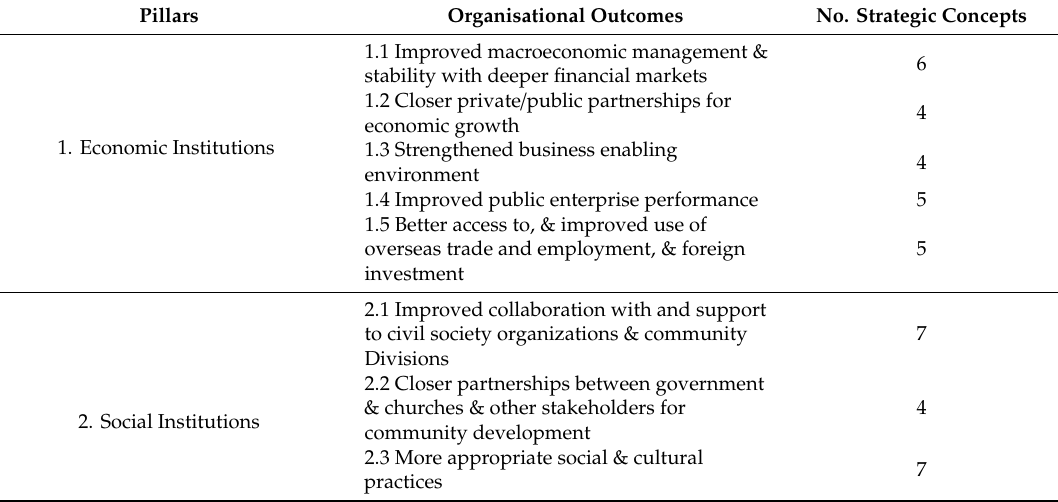
Table A1. The Pillars and associated Organisational Outcomes and number of Strategic Concepts connected with each OO in the TSDFII